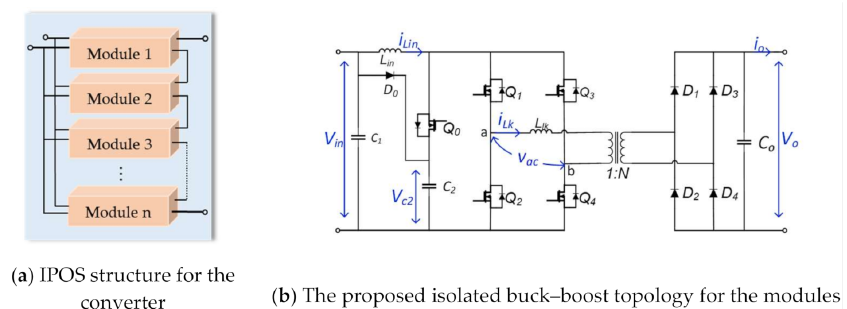
Figure 2. Topology of the proposed MVDC